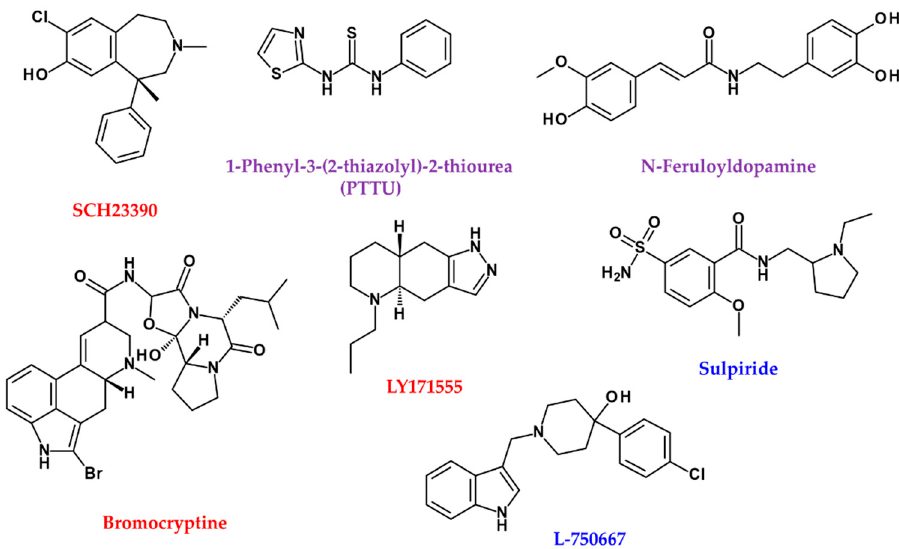
Figure 4. Chemical structures of agonist (red), antagonist (blue), and enzyme inhibitors or others (purple) related to DA neurotransmitters.